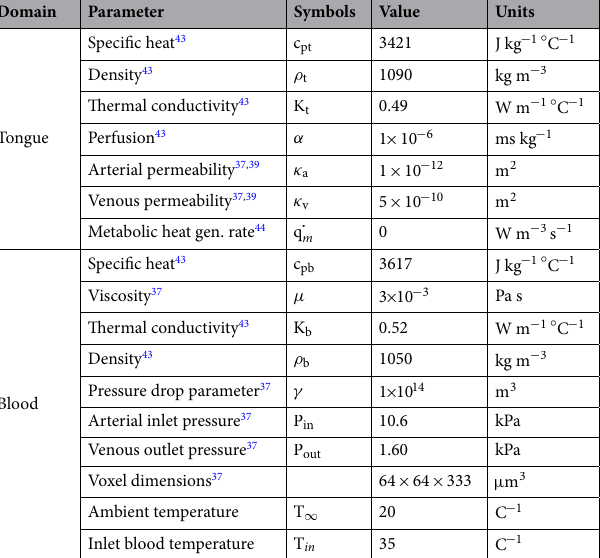
Table 1. Parameters used for